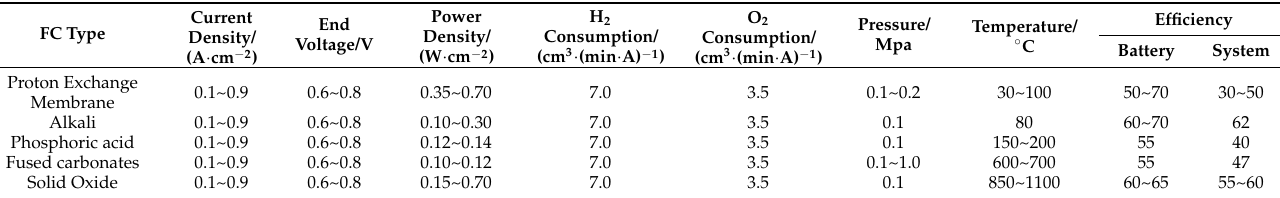
Table 8. The characteristic parameters of these five fuel